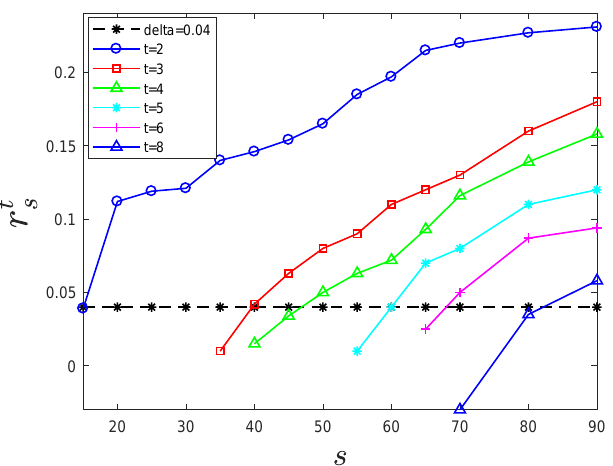
Figure 3. The accuracy increase of different t unknown subclasses compared with the original